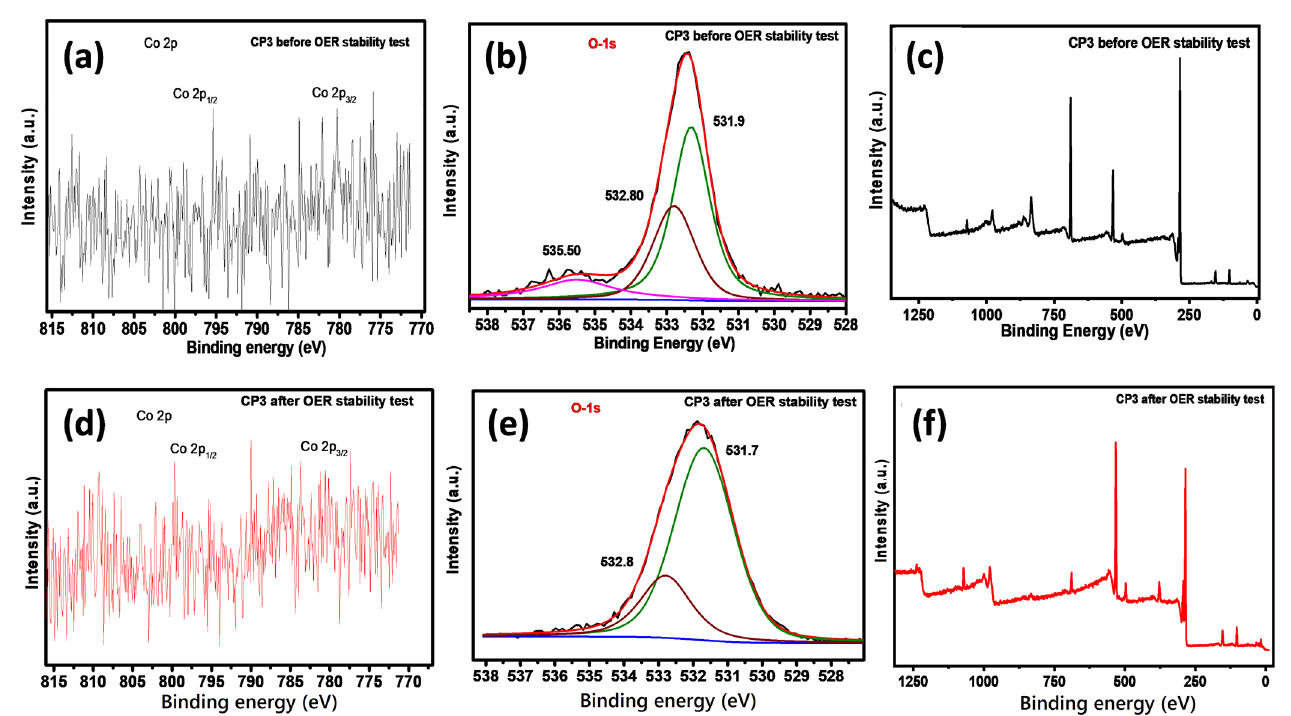
Figure 7. XPS spectra of Co 2p and O 1s in sample CP3; ( a ) XPS spectra representing the oxidation state of Co 2p before OER; ( b ) resolved XPS spectra representing the oxidation state of O 1s before OER; ( c ) Survey scan of CP3 before OER stability Test; ( d ) XPS spectra representing the oxidation state of Co 2p after OER; ( e ) resolved XPS representing oxidation state of the O 1s after OER; ( f ) survey scan of CP3 after OER stability test.